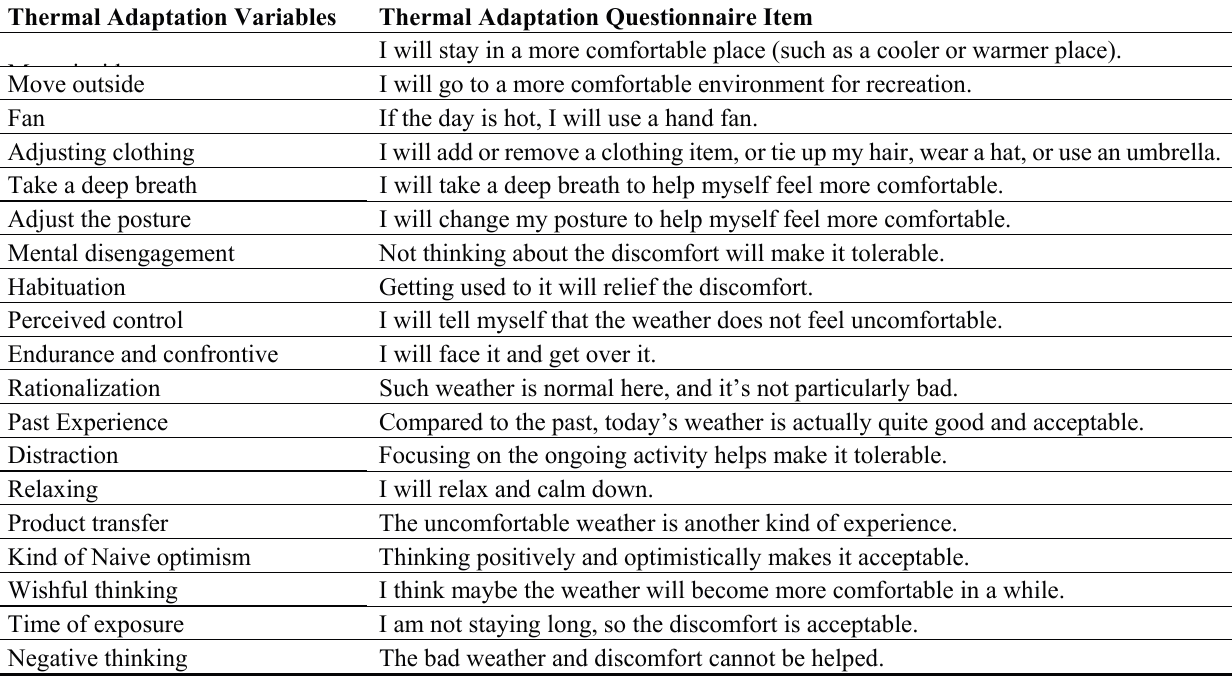
Table 3. Thermal adaption questionnaire items for urban plaza users in hot and humid Asia (detailed